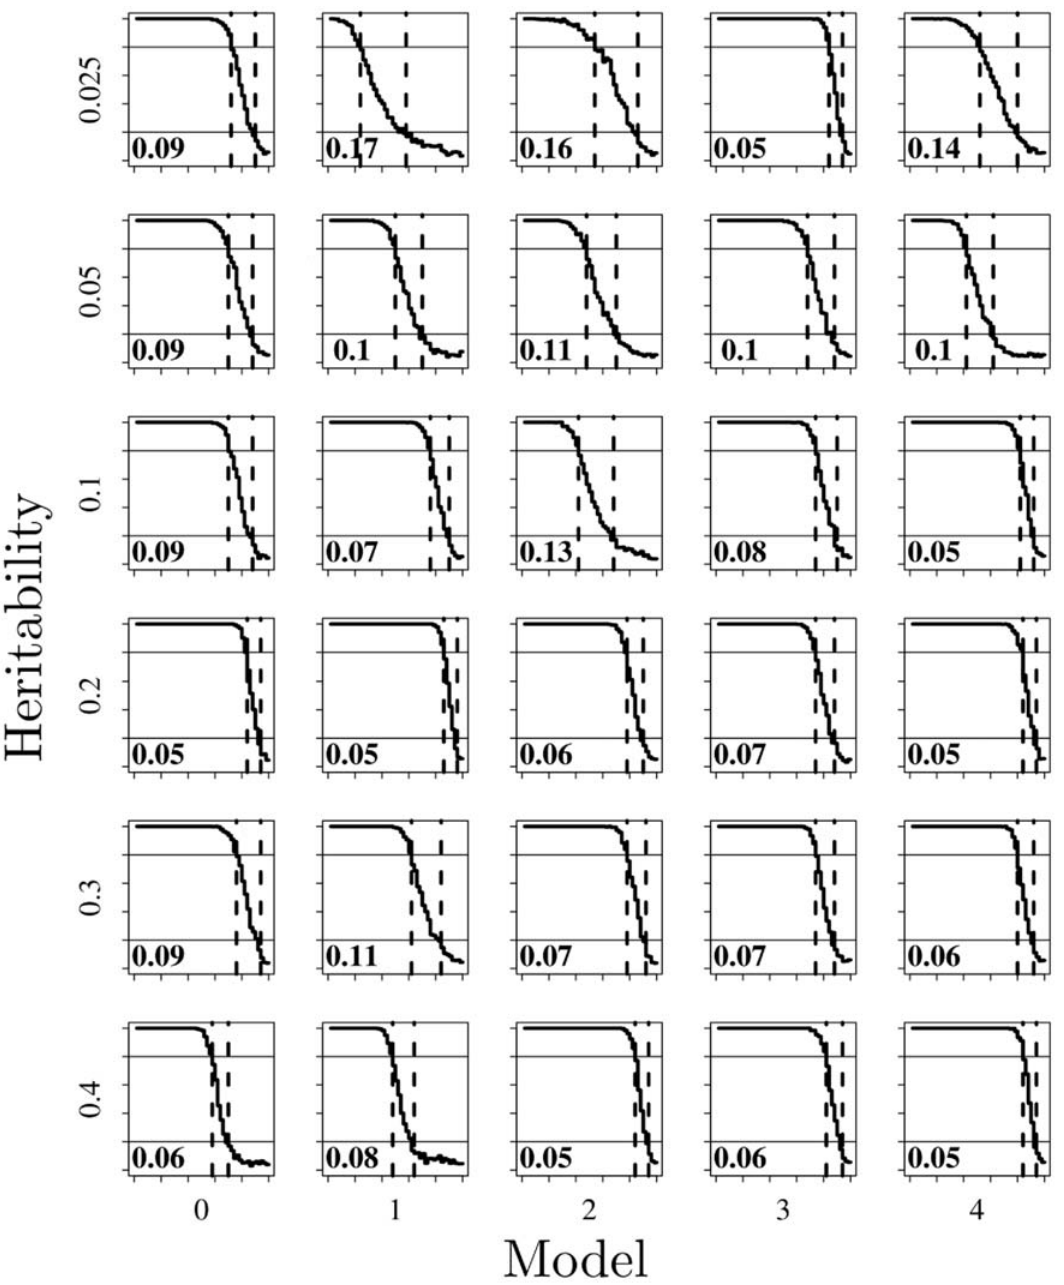
Figure 2. This figure summarizes power for many models and heritabilities. The effect described in Figure 1 is consistent across very large to very small heritability models (0.4 to 0.025). In most cases a change in allele frequency of less than 0.1 is enough to reduce the power to replicate a main effect from 80% to 20%. Results shown are for a sample including 800 cases and 800 controls. Results with datasets containing 400 and 800 individuals are similar and can be found in supplementary figures S1 and